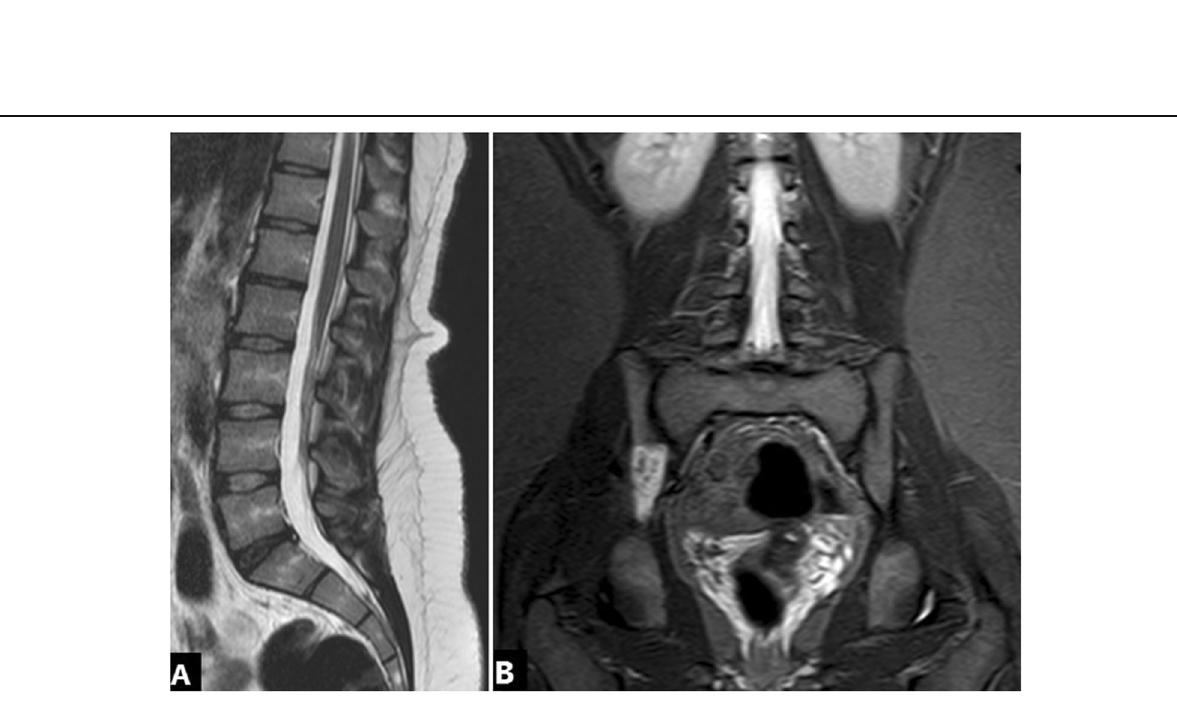
Fig. 4 A 22-year-old female patient, presenting with right sciatica. The patient is known to have pancreatic neuroendocrine tumor. a Routine MR protocol images revealed mild spondylodegenerative changes and L5/S1 tiny disc protrusion. No signs of nerve root impingement on other images. b Additional coronal STIR images revealed right iliac bone lesion. Bone scan revealed metastatic bone